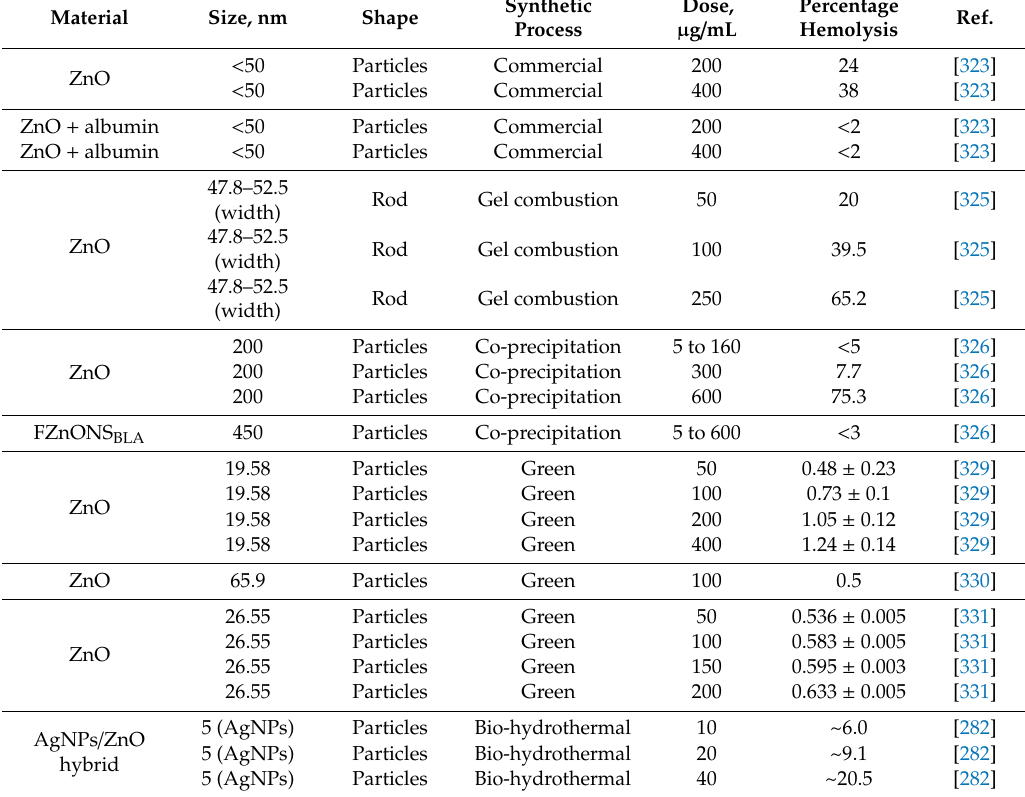
Table 2. The percentage hemolysis of erythrocytes treated with ZnO nanostructures.